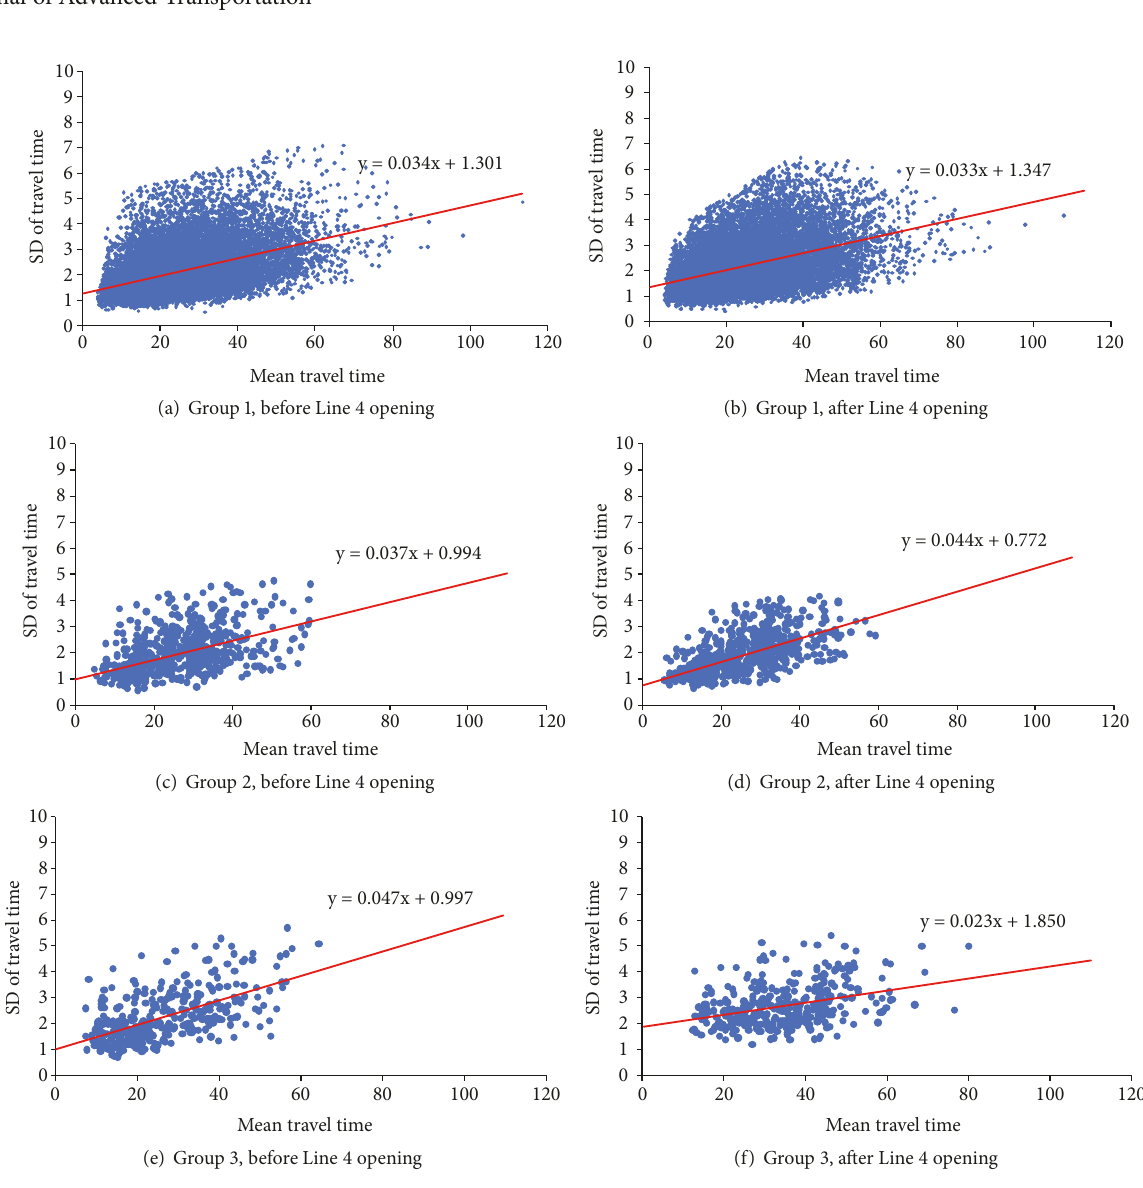
Figure 10: The mean and the SD of commuting travel time before and after Line 4